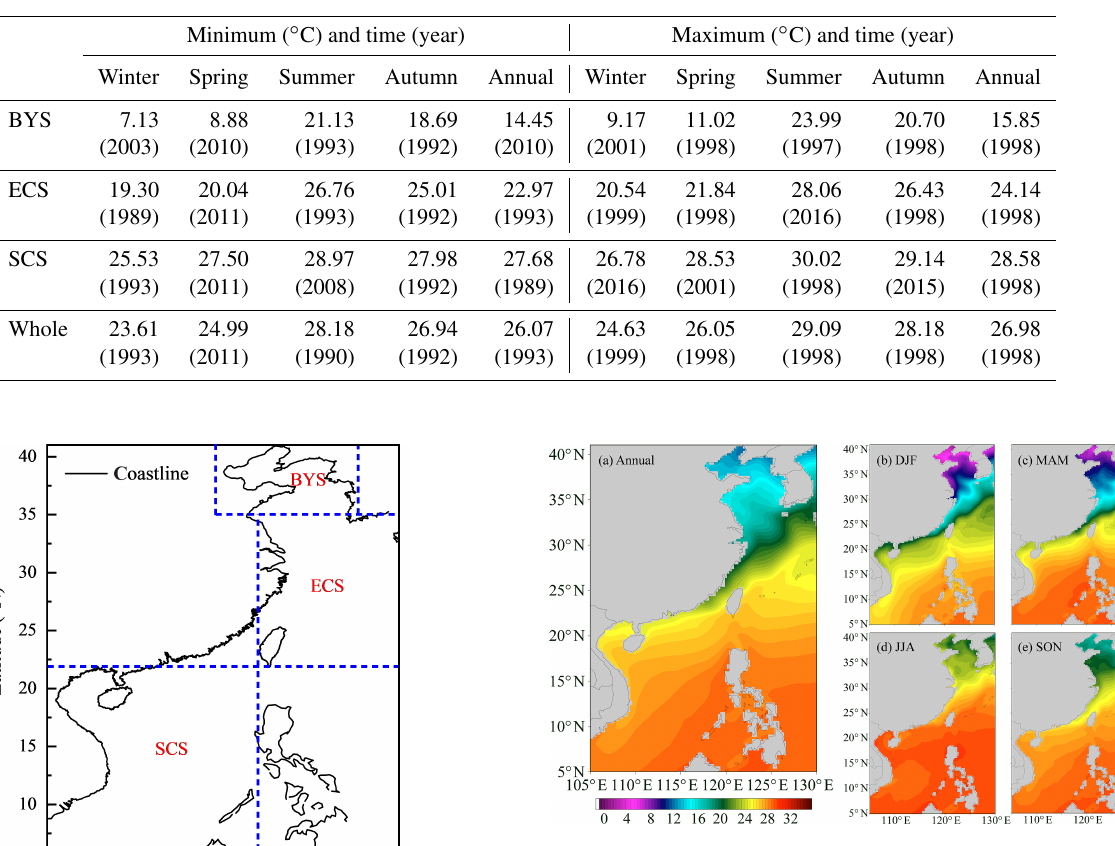
Figure 11. Annual (a) and seasonal (b, c, d, e) mean SST distri- bution during 1988–2017 in the China Sea: (a) annual; (b) winter: DJF; (c) spring: MAM; (d) summer: JJA; (e) autumn: SON. Figure 7 shows the spatial distribution of seasonal and an- nual mean SSTs during the 1988–2017 period. As can be seen from the figure, the spatial distribution of average SST in each season and annually is similar, and similar to the monthly results (Fig. 6). In the low-latitude region, the SST is higher but in the high latitudes. SST is relatively low. An- nual mean SST decreases with increasing latitude, with high temperature ranging from 26 to 28 ◦ C in the south and low temperature ranging from 3 to 6 ◦ C in the north, which is closely related to the solar radiation distribution in the deep- sea region. The isotherm is northeast–southwest oriented